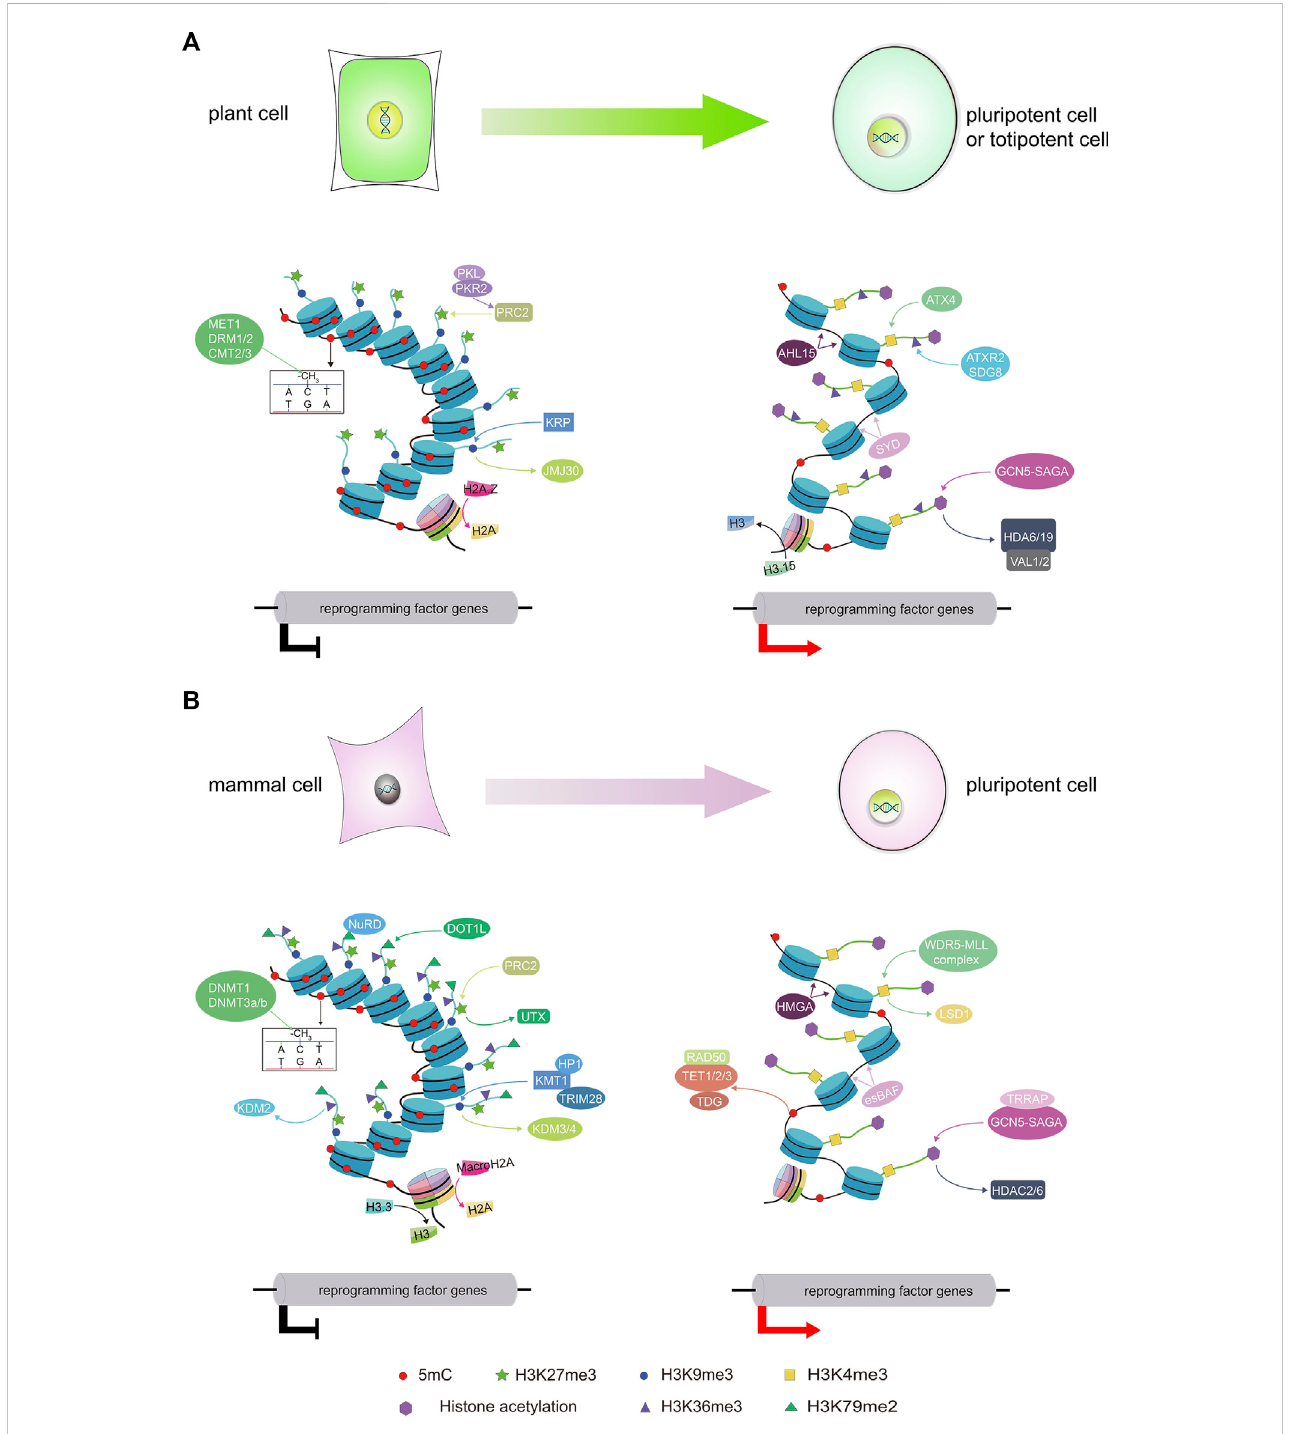
FIGURE 1 An overview of epigenetic factors dynamically regulating the chromatin state during somatic cell reprogramming. The diagrams illustrate the reprogramming of somatic cells to pluripotent or totipotent cells along with the associated epigenetic modi fi cations in plants (A) and mammals (B) . DNA methylation acts as a barrier during SCR in both mammals and plants. Most pluripotency or totipotency genes are hypermethylated and transcriptionally silenced in somatic cells, and they are (re) activated through active DNA demethylation during SCR. Histone methylation is also required for SCR. Different histone methylation marks induce open or repressive chromatin states, ensuring the activation of pluripotency or totipotency genes to promote SCR. Histone acetylation acts as an epigenetic activator of reprogramming by establishing a chromatin structure that promotes the activation of a transcriptionalnetworkthat regulates pluripotency or totipotency. Histone variants and chromatinremodeling are also associated with histone modi fi cations and impose a repressive chromatin state to prevent the reactivation of critical pluripotency or totipotency genes during